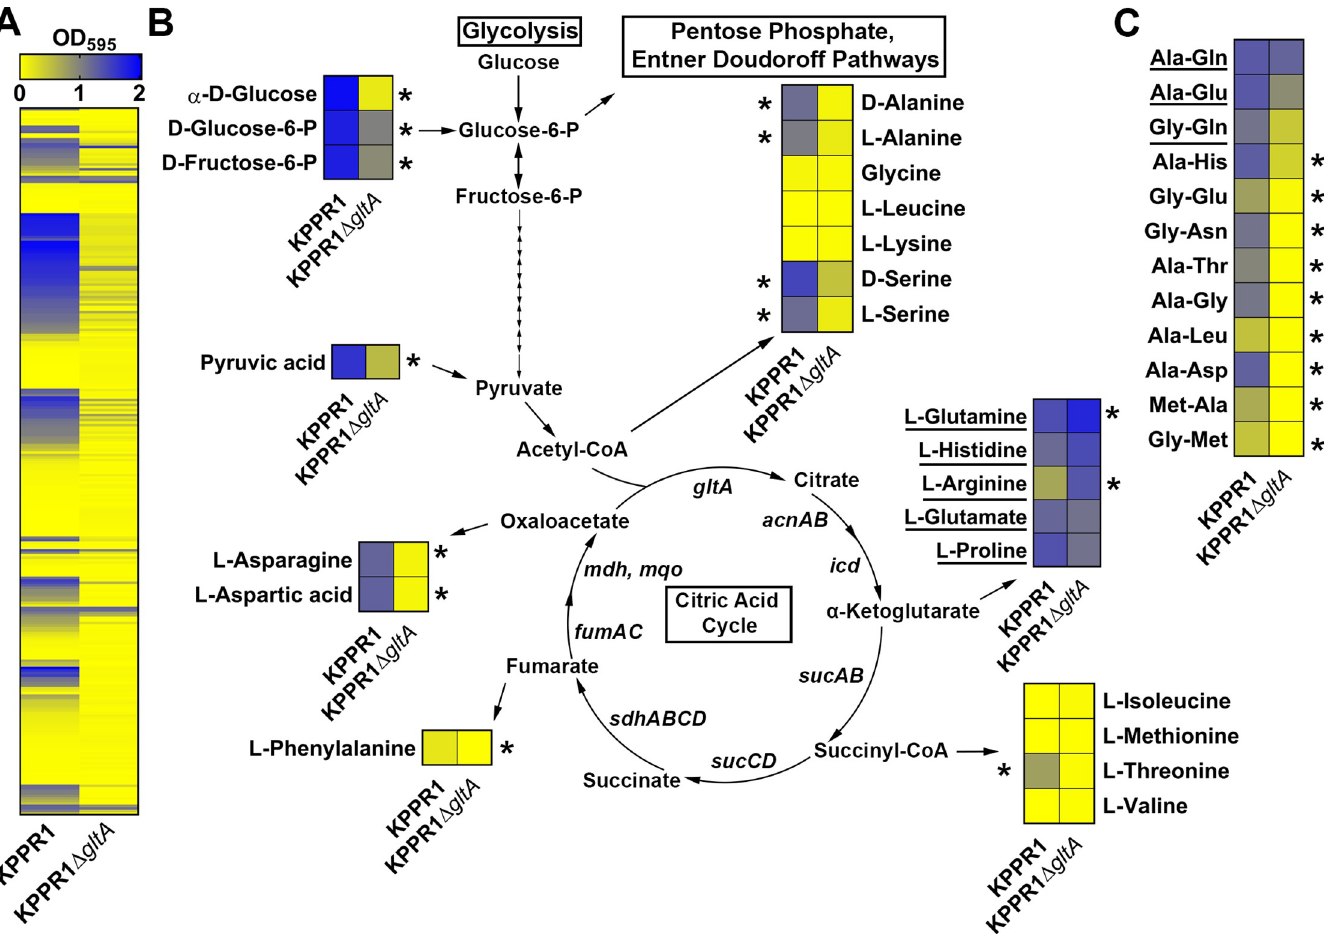
Fig 2. Deletion of gltA leads to diminished metabolic flexibility and distinct amino acid auxotrophy. (A) Heatmap summarizing BioLog Phenotype Microarray analysis of WT KPPR1 and KPPR1 Δ gltA growth in 282 carbon and nitrogen limited growth conditions indicates multiple conditions that sustained growth of WT KPPR1, but not KPPR1 Δ gltA . (B) A subset of growth conditions summarizing glycolysis and non-essential amino acid biosynthesis that indicates a distinct amino acid auxotrophy is induced by deletion of gltA . Arrows from citric acid cycle intermediates indicate amino acids that utilize these intermediates for biosynthesis. (C) A subset of growth conditions summarizing dipeptide utilization that further indicates induction of a distinct amino acid auxotrophy by deletion of gltA (n = 3, mean displayed, � P < 0.05, Student’s t test). Underlined substrates support equivalent or enhanced growth of KPPR1 Δ gltA relative to WT